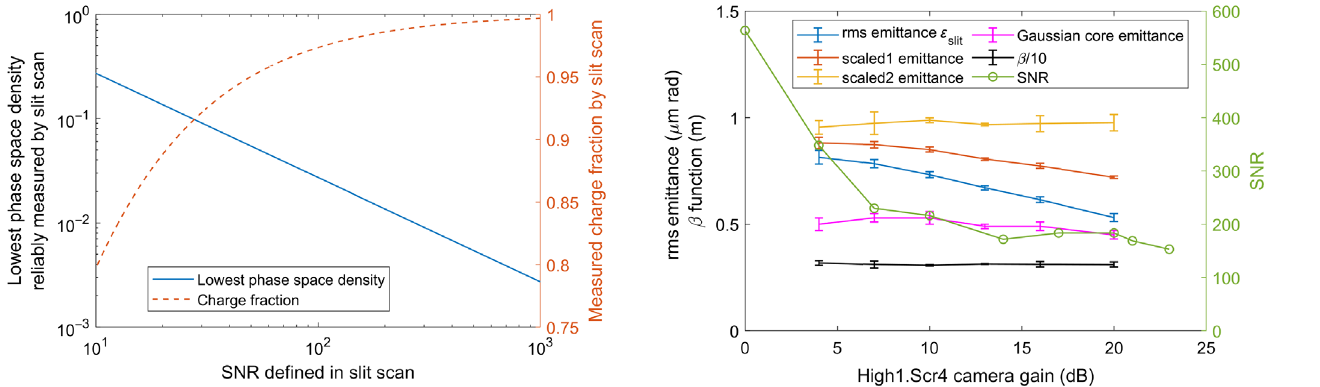
FIG. 4. Analytical estimation of lowest phase space density (normalized by the peak density) that can be reliably measured in slit scan vs SNR, assuming a Gaussian phase space. The measured charge fraction by slit scan is estimated by Eq. (17).